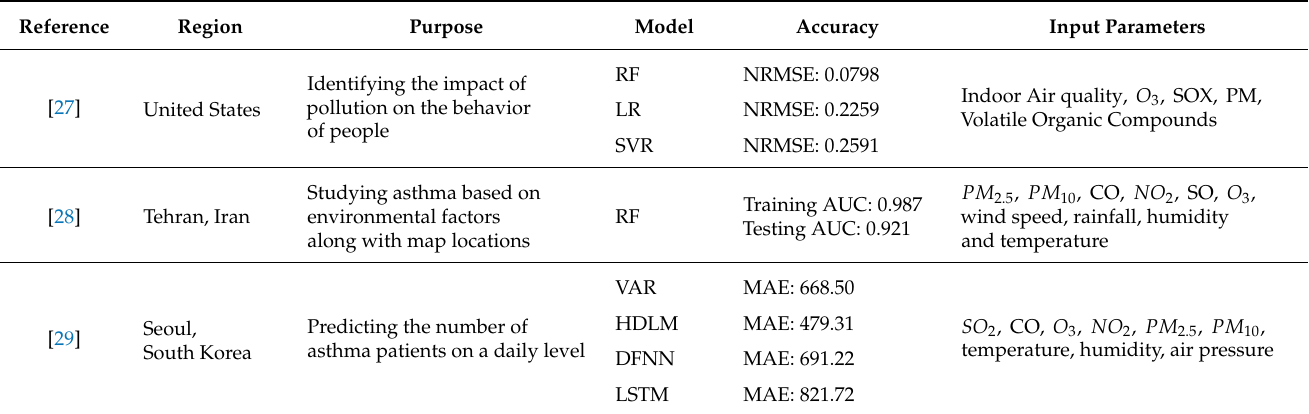
Table 2. Literature survey of the air pollution impact to human health (created by